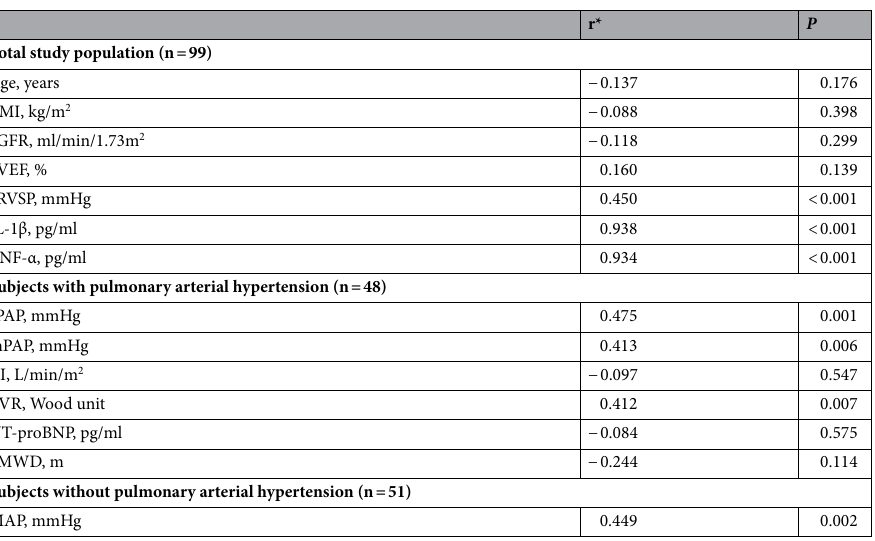
Table 2. Correlations of TIFA with baseline characteristics and pulmonary arterial hemodynamics by using linear regression analysis. 6MWD, 6-min walk distance; BMI, body mass index; CI, cardiac index; eGFR, estimated glomerular filtration rate; eRVSP, estimated right ventricular systolic pressure; IL-1β, interleukin-1β; LVEF, left ventricular ejection fraction; MAP, mean arterial pressure; mPAP, mean pulmonary artery pressure; NT-proBNP, N-terminal pro-B type natriuretic peptide; PVR, pulmonary vascular resistance; sPAP, systolic pulmonary artery pressure; TIFA, tumor necrosis factor-α receptor-associated factor-interacting protein with a forkhead-associated domain; TNF-α, tumor necrosis factor-α. *r: Pearson’s correlation coefficient.